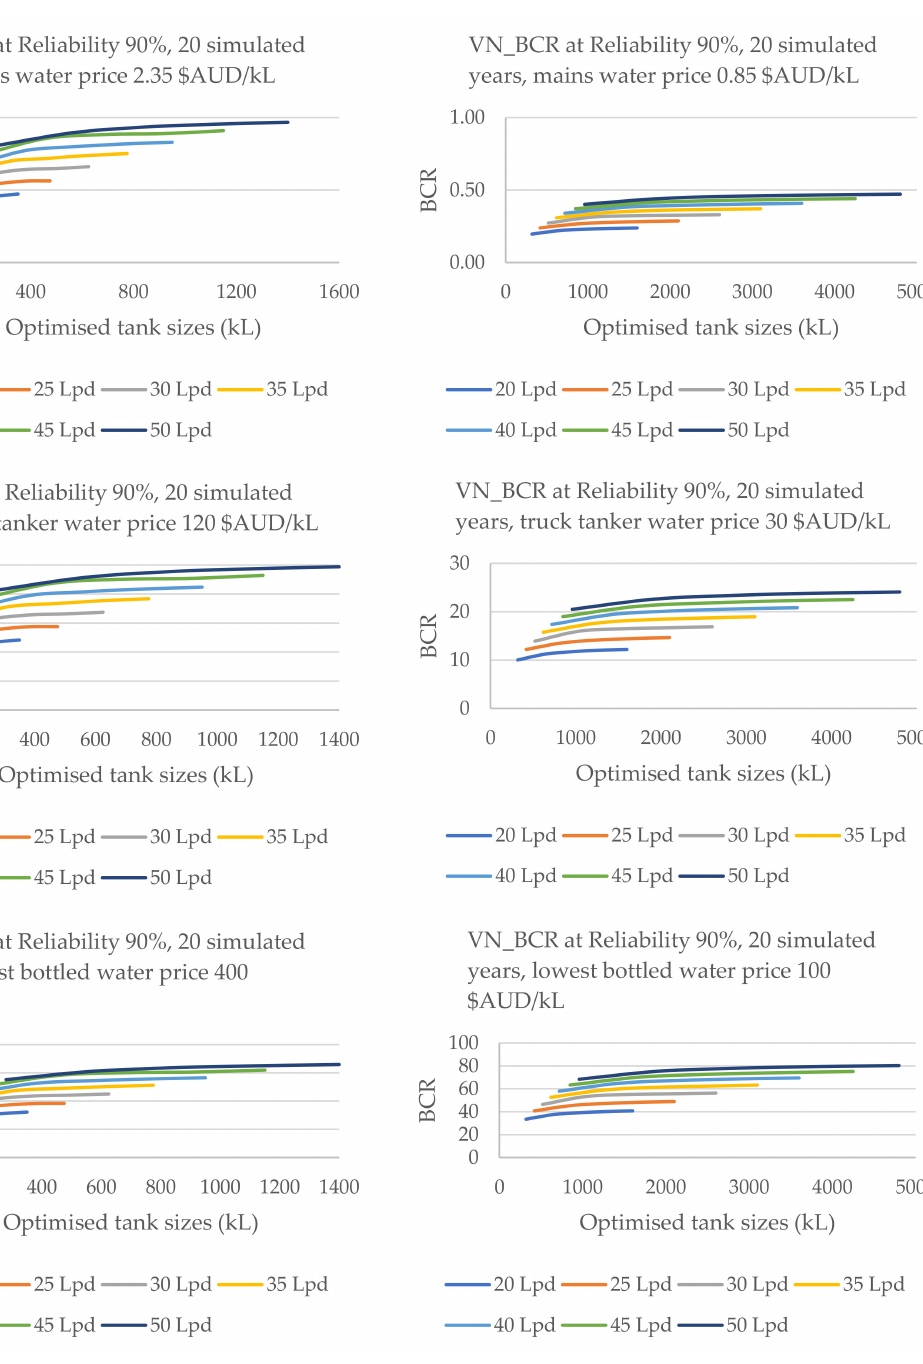
Figure 11. BCR values for the Australian and Vietnamese RWH systems considering reliability 90%, 20-year lifespan at mains, truck tanker and bottled drinking water